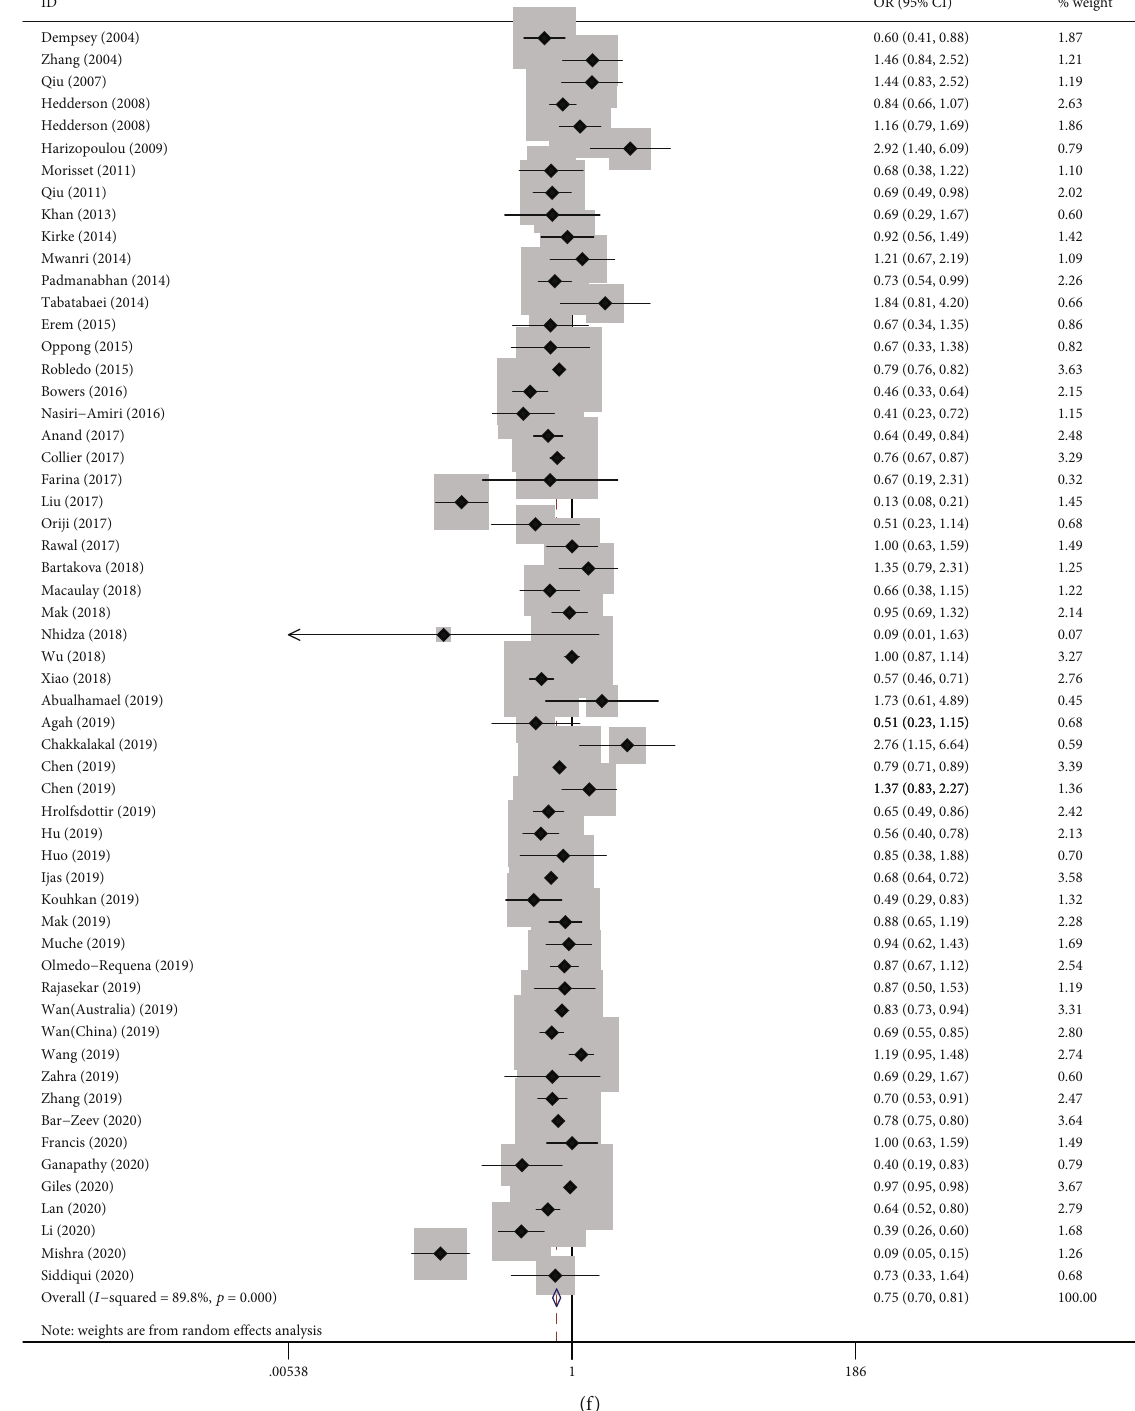
Figure 3: Forest plot for previous history of obstetric factors associated with GDM: (a) macrosomia; (b) stillbirth; (c) premature delivery; (d) abortion; (e) congenital anomaly; (f)